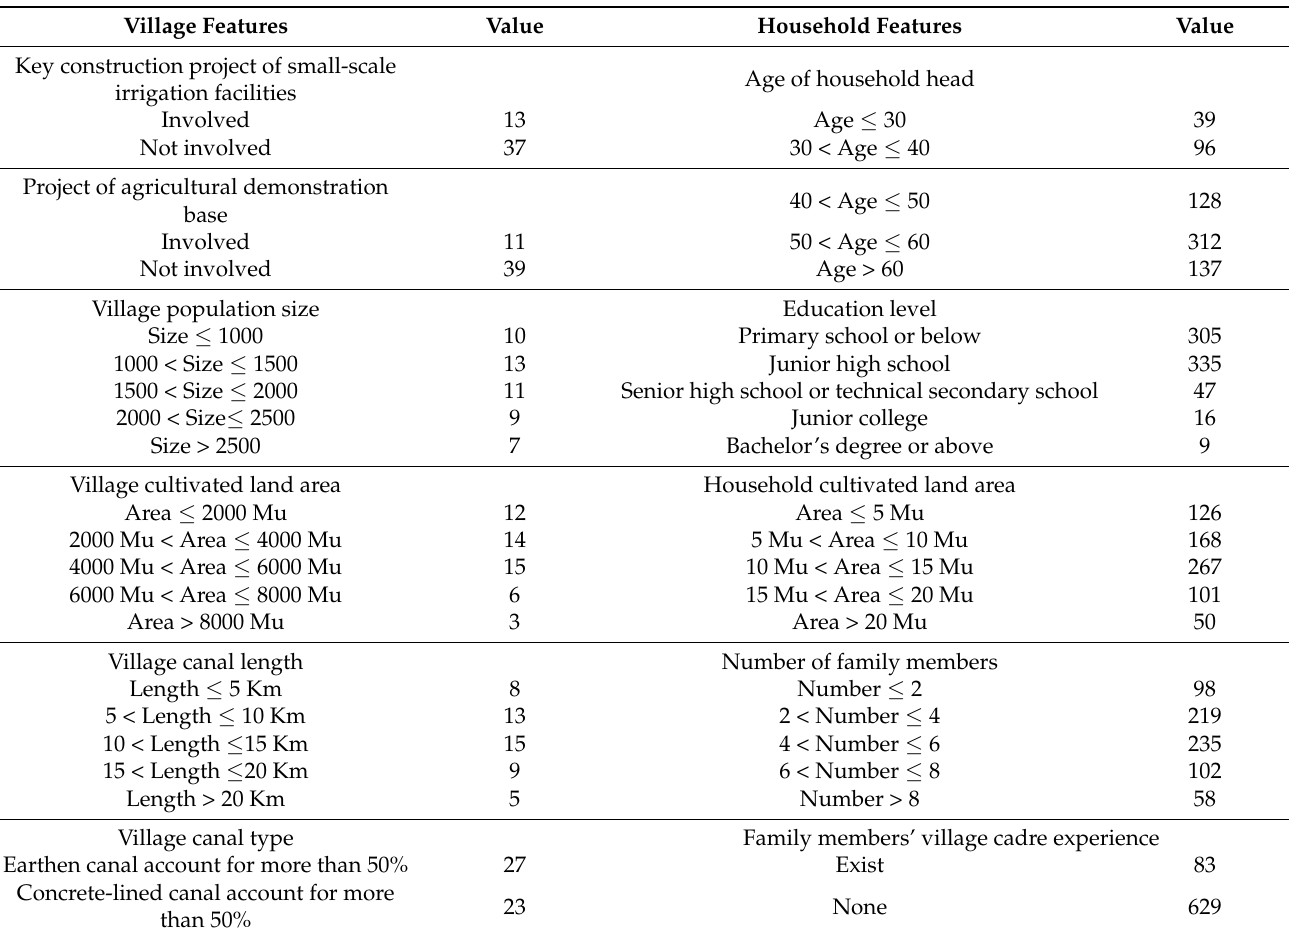
Table A1. Summary statistics of sampled villages and